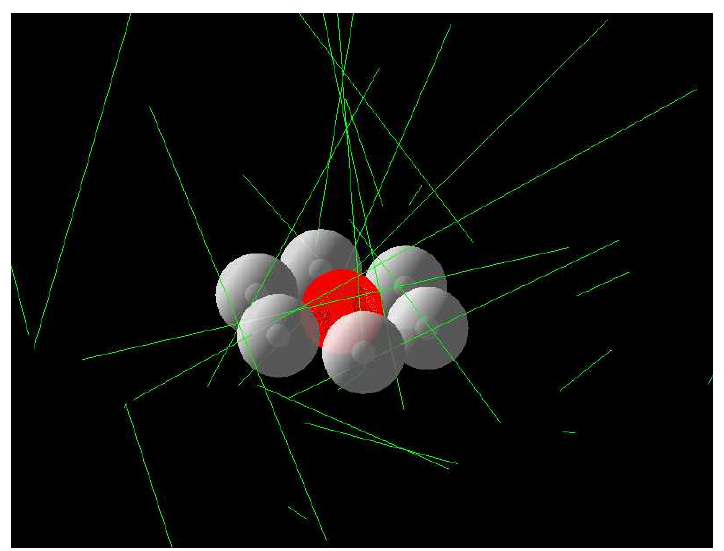
Figure 12. Geometry of the microdosimetric model; 25 neutrons were generated, some cells were hidden, and the central cell is sensitive.